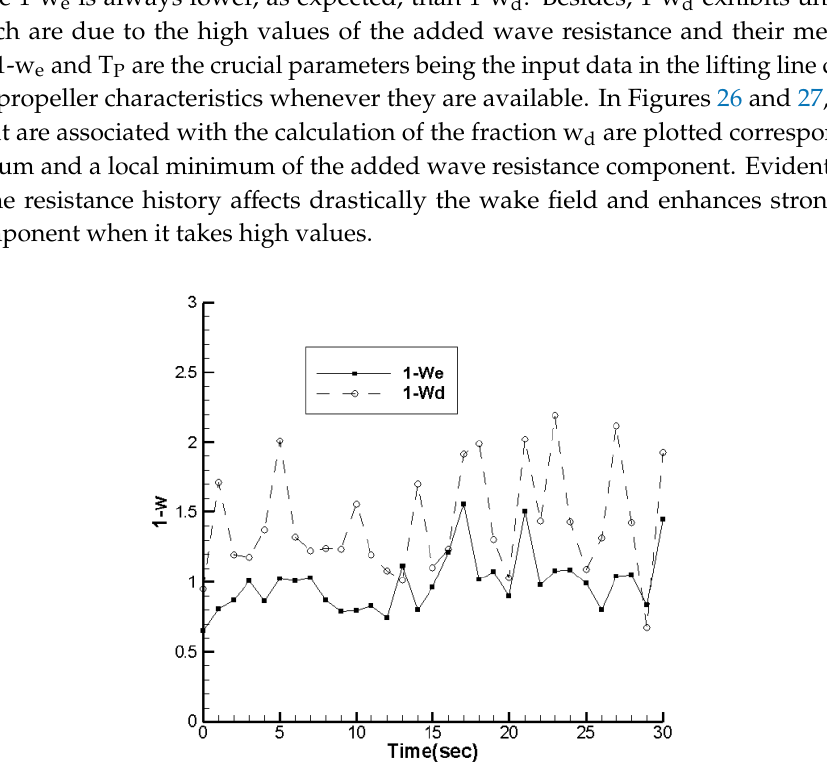
Figure 25. Time histories of real (1 ‐ w d ) and effective (1 ‐ w e ) wake fractions, numerical experiment #1.